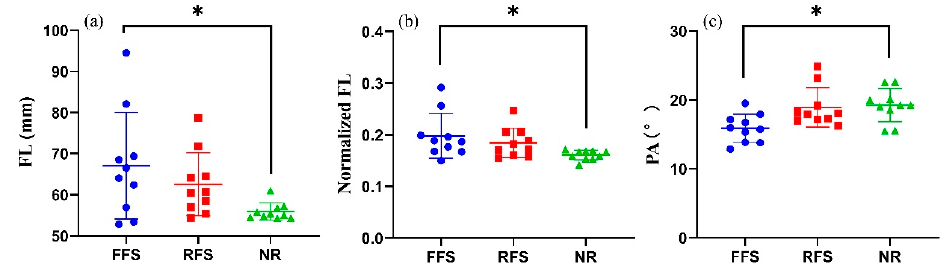
Figure 4. Effects of habitual foot strike patterns on the FL ( a ), normalized FL ( b ), and PA ( c ) of MG. Note: * p < 0.05. FFS: habitual forefoot strikers; RFS: habitual rearfoot strikers; NR: nonrunners; FL: fascicle length; normalized FL: FL divided by the shank length; PA: pennation angle.